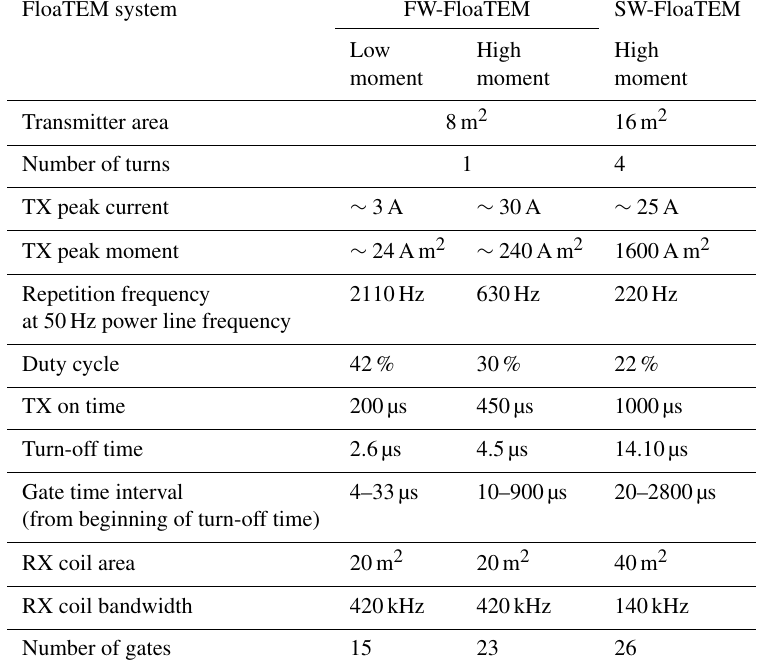
Table 1. System parameters for the freshwater and saltwater FloaTEM